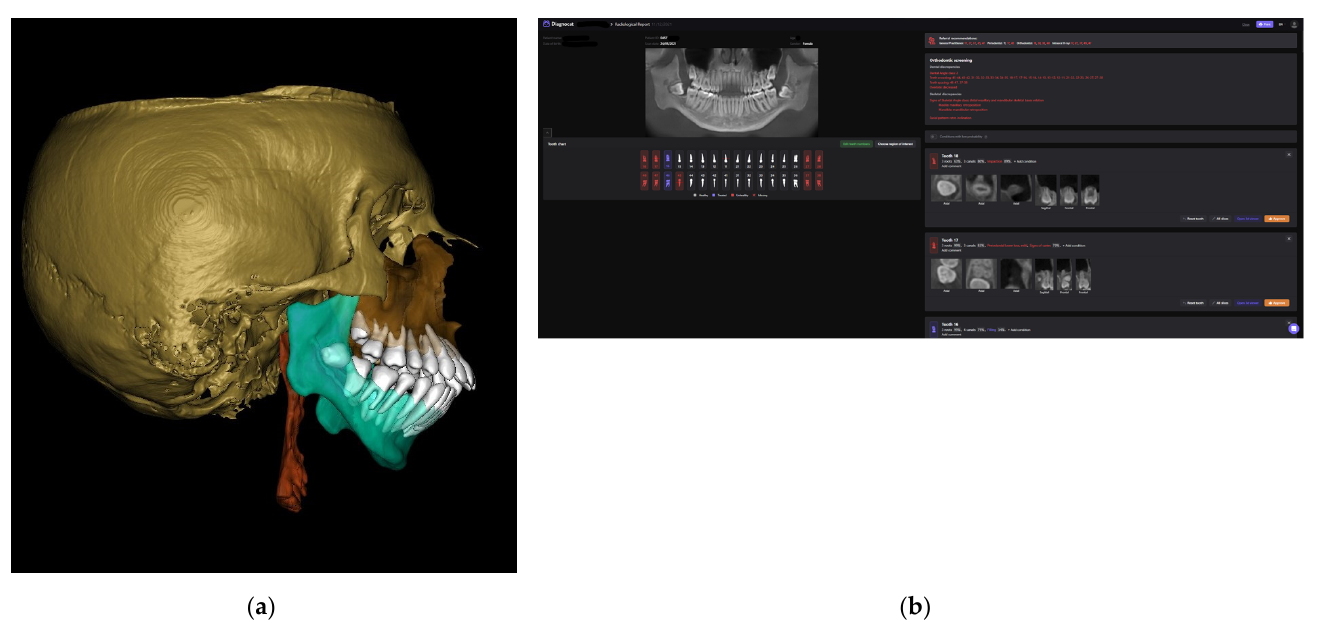
Figure 6. AI automated process of CBCT analysis: ( a ) lateral view of result of AI-automated seg- mentation with various segmented structures that can be exported to STLs or visualized in different colors and opacities; ( b ) results of AI-automated dental analysis focused on caries and other tooth or bone parameters.